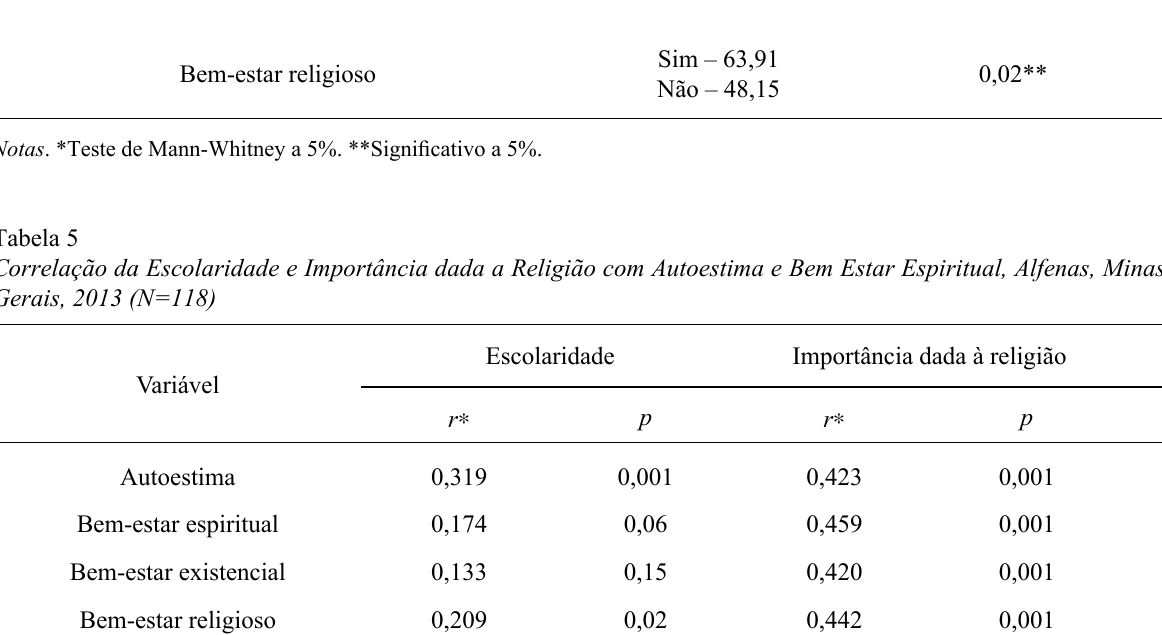
Nota . ∗ Coe fi ciente de Correlação de